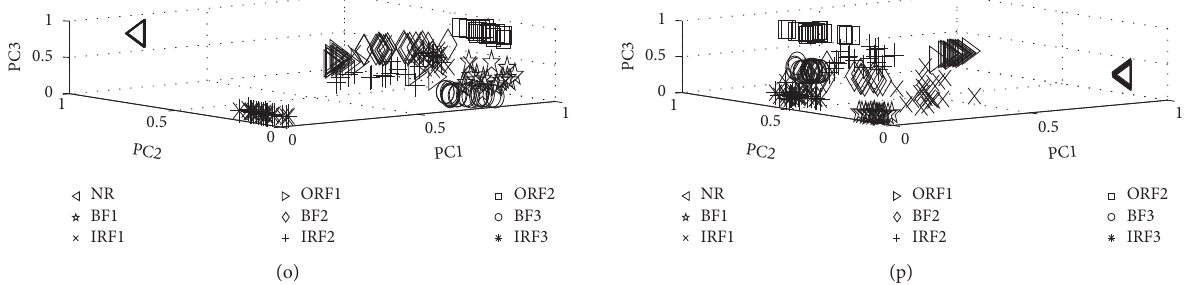
Figure 13: The 3-dimensional results of different datasets for the testing dataset through eight hidden layers by using an SAE with PCA dimension reduction; 1–8 denote the hidden layer number. (a) SAE-A-512-testing data. (b) SAE-B-512-testing data. (c) SAE-A-256-testing data. (d) SAE-B-256-testing data. (e) SAE-A-128-testing data. (f) SAE-B-128-testing data. (g) SAE-A-64-testing data. (h) SAE-B-64-testing data. (i) SAE-A-32-testing data. (j) SAE-B-32-testing data. (k) SAE-A-16-testing data. (l) SAE-B-16-testing data. (m) SAE-A-8-testing data. (n) SAE-B-8-testing data. (o) SAE-A-3-testing data. (p) SAE-B-3-testing data.